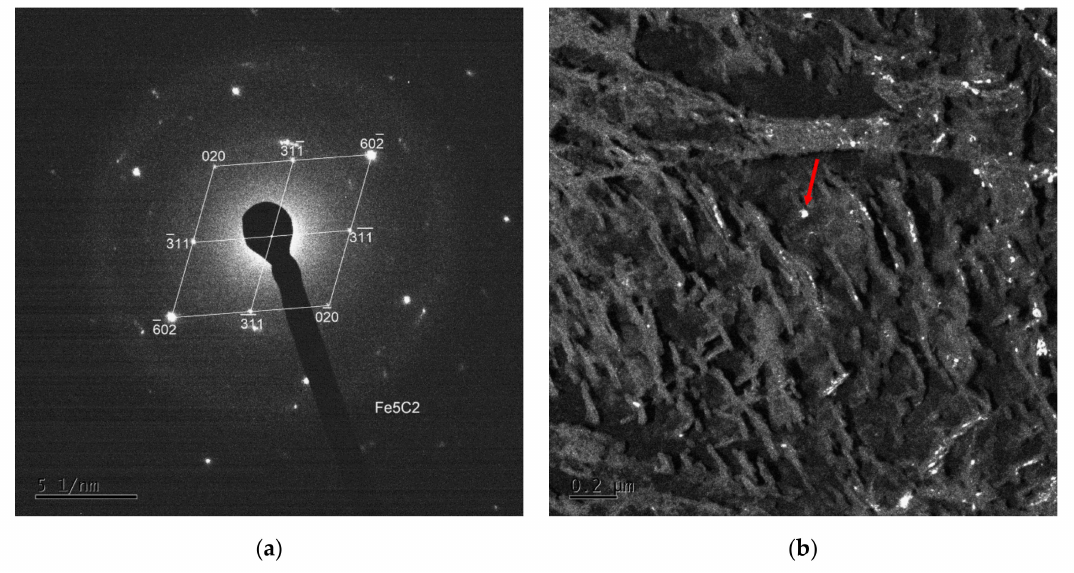
Figure 10. Selected area electron diffraction (SAED) pattern ( a ) and dark field mode of an extracted particle of Fe 5 C 2 Hägg carbide (indicated by the red arrow) diffracting in the dark field ( b ). The dislocation density-tempering temperature diagrams for QT and SAT materials are depicted in Figure 11. Both curves show decreasing trends as the tempering temperature increases. Lower values of dislocation densities were determined for samples treated by the SAT regime. The difference between dislocation densities of QT and SAT samples decreased with increasing tempering